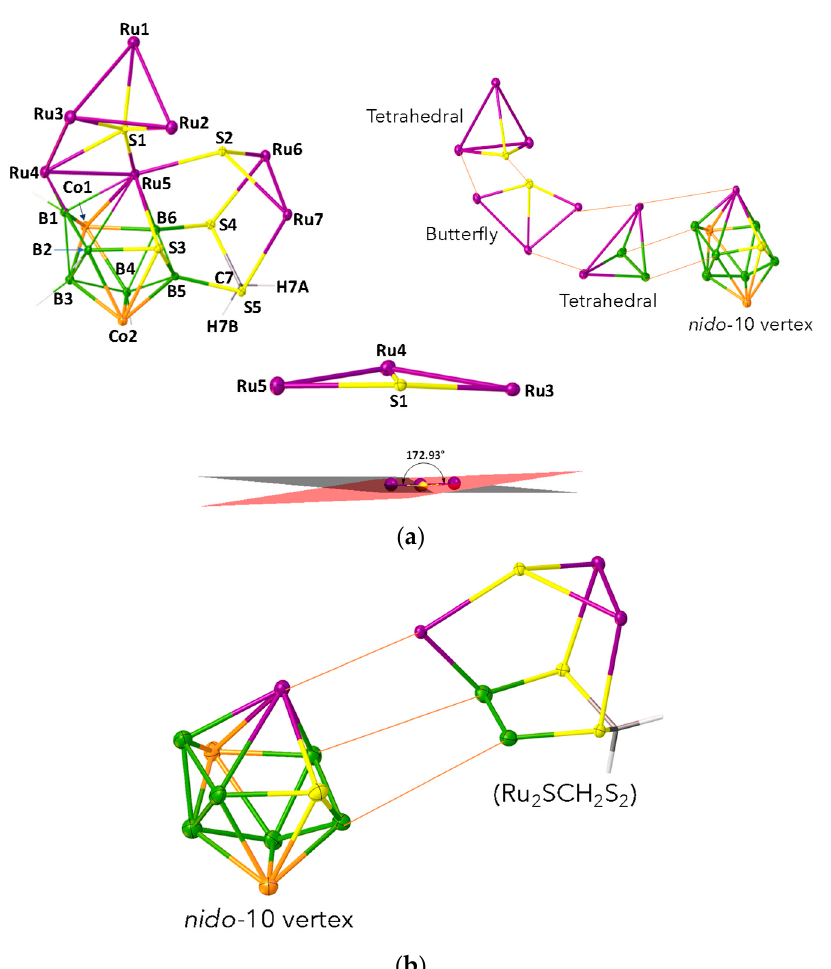
Figure 4. ( a ) Molecular structure, labelling diagram (left), fusion demonstration (right) and demon- stration with dihedral angles between planes of Ru5 − S1 − Ru4 and Ru4 − S1 − Ru3 triangles of {Ru 3 S} butterfly subcluster (bottom), of 7 (note that Cp* ligands and carbonyl groups attached to metals are omitted for clarity). Selected bond lengths (Å) and angles (°): 7 : Ru1 − S1 2.3488(18), Ru3 − S1 2.4798(18), Ru4 − S1 2.5153(18), Ru3 − Ru4 3.0572(8), Ru7 − S2 2.4311(17), S5 − C7 1.821(7); Ru5 − S1 − Ru3 145.51(8), Ru4 − S1 − Ru3 75.47(5). ( b )Fusion of nido -10 vertex {Co 2 B 6 RuS} and {Ru 2 SCH 2 S 2 } cores of 7 . (Cp* ligands and carbonyl groups attached to metals are omitted for clarity).